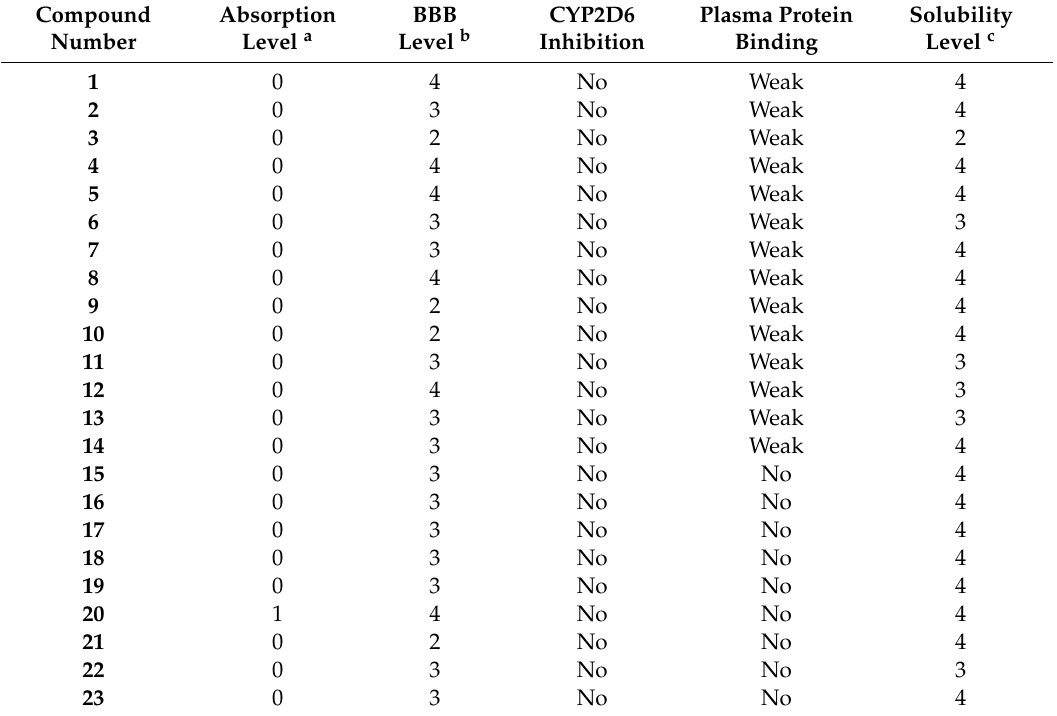
Table 1. Chemical names and pharmacokinetic parameters of 23 compounds selected after absorption, distribution, metabolism, excretion, and toxicity (ADME / T)